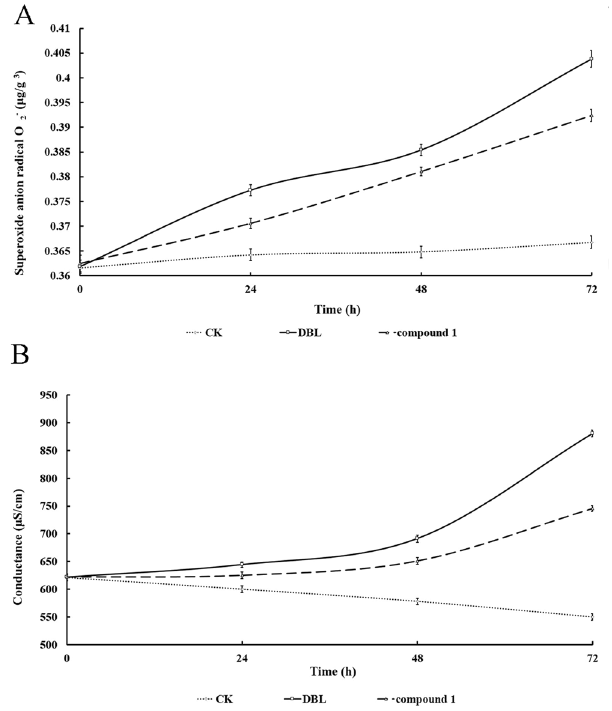
Figure 3. Influences of DBL and compound 1 (4 μ g/mL) on O 2 •− and EC of M. aeruginosa cells,